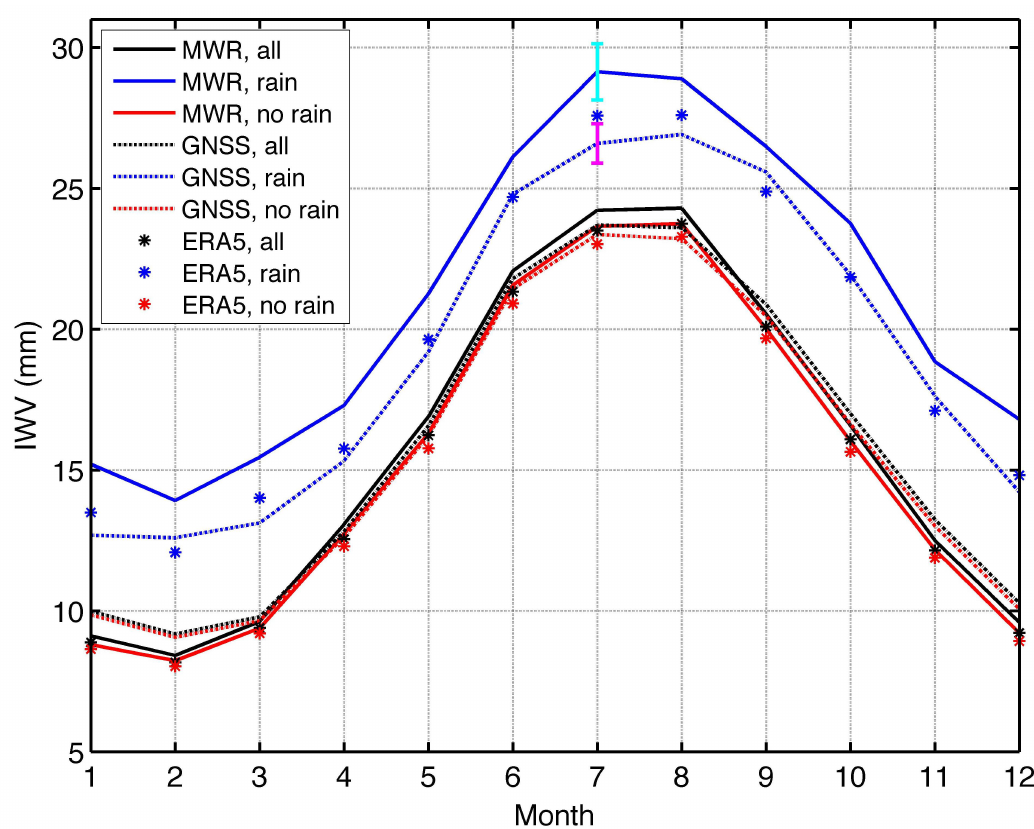
Figure 5. Climatology of IWV at Bern from 2004 to 2016. Rain periods are indicated by integrated liquid water (ILW) ≥ 0.4 mm as observed by the microwave radiometer (MWR) TROWARA.